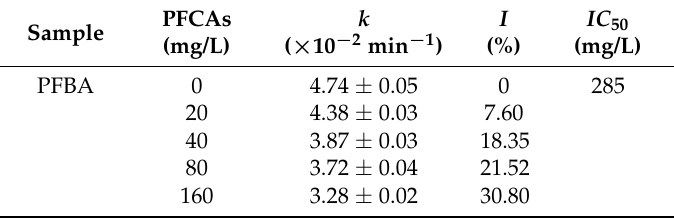
Figure 3. Dose-response relations for single toxicities of PFCAs. PFBA: perfluorobutyric acid; PFHxA: perfluorohexanoic acid; PFDA: perfluorodecanoic acid. Table 1. Effect of single exposure to PFCAs in k , I , and IC 50 .